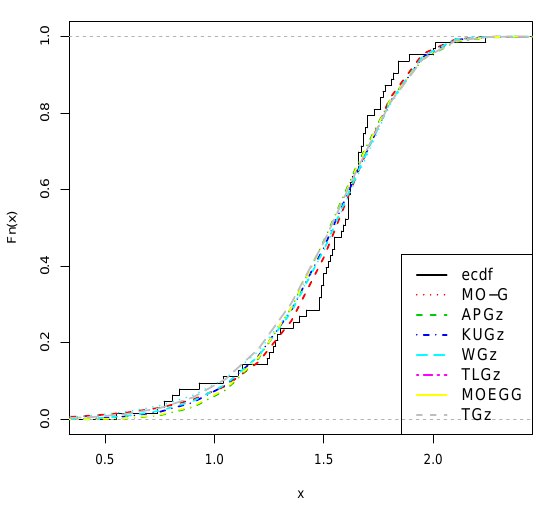
Figure 6 – The plots of estimated cdf of the MO-G model.